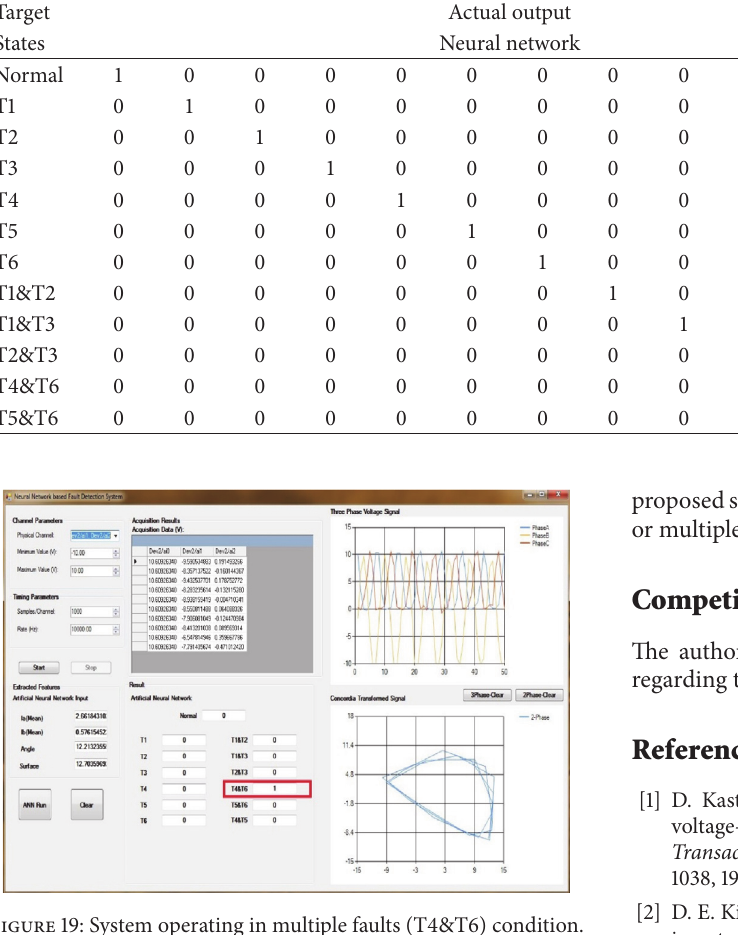
Figure 19: System operating in multiple faults (T4&T6)